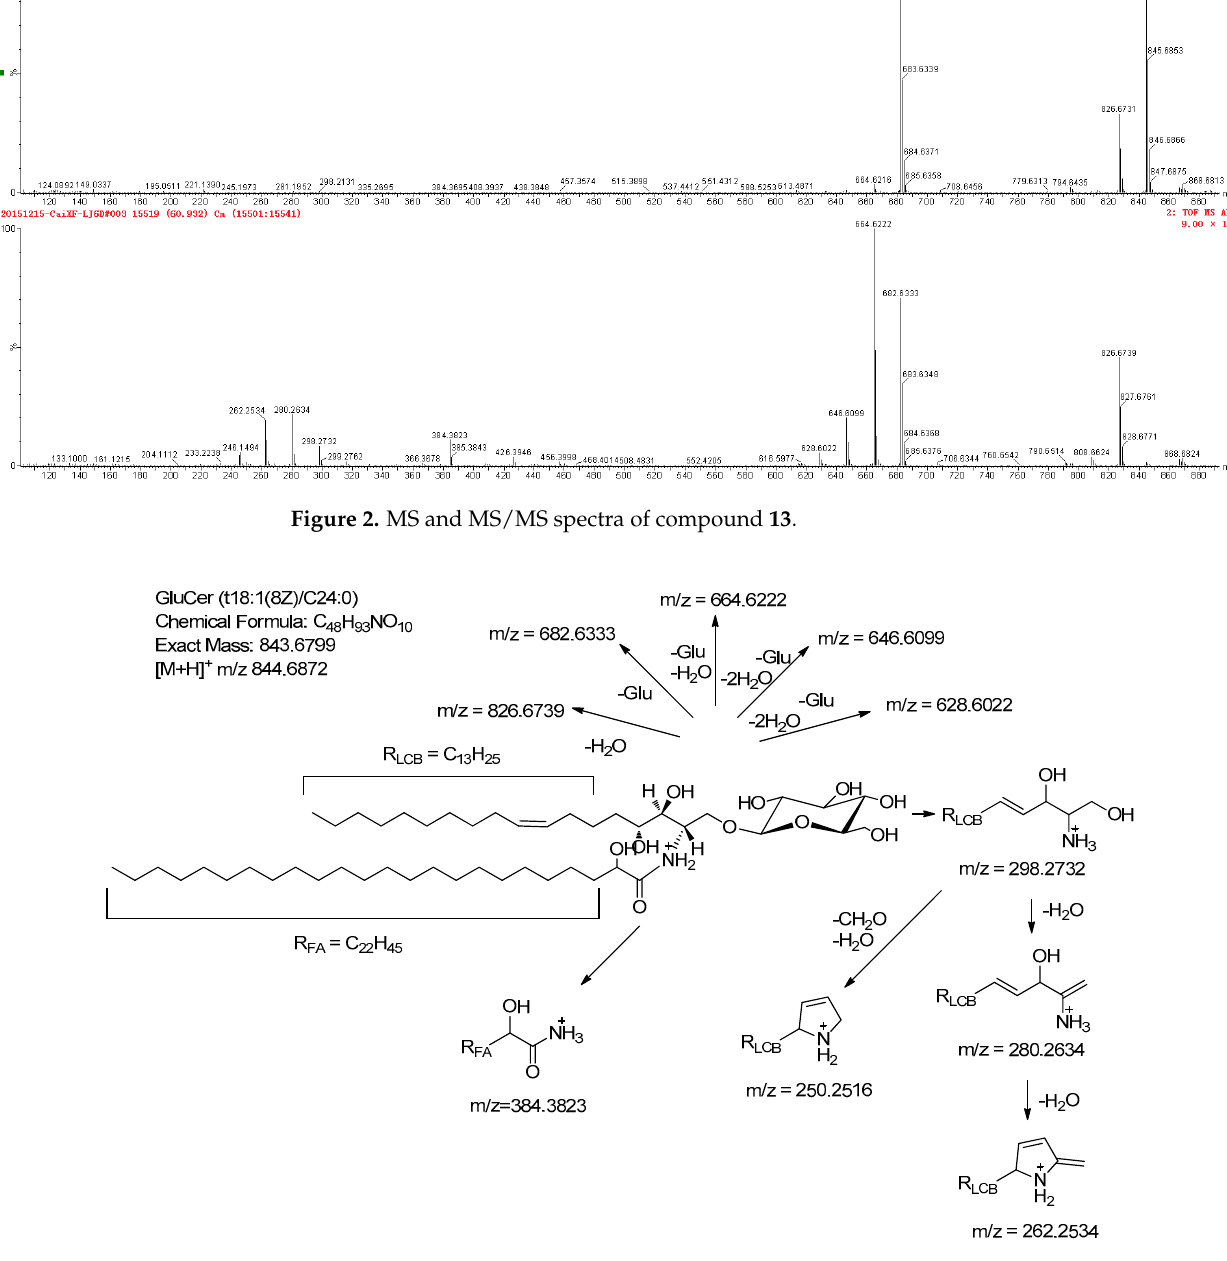
Peak NO. in Figure